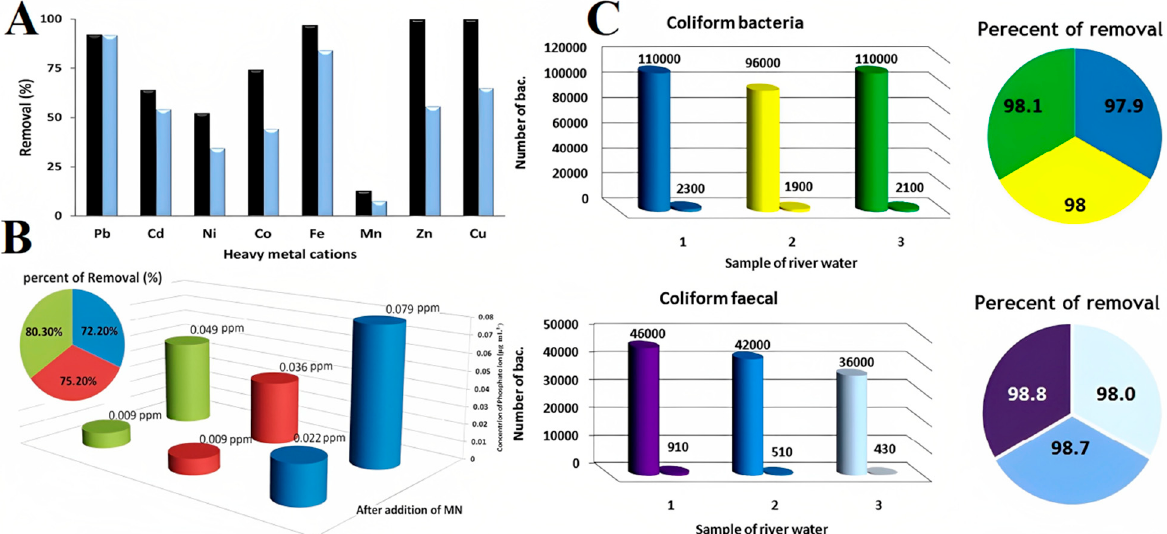
Figure 13. ( A ) Removal percentage of heavy-metal cations with MNPs at two different concentrations of heavy-metal cations and constant water volume (conditions: adsorbent, 0.15 g; volume, 200 mL; concentrations of heavy metal cations, 1 μ g·mL − 1 (black bar) and 4 μ g·mL − 1 (blue bar); temperature, 25 °C); ( B ) effect of MNPs on phosphate ion removal. Concentrations before and after treatment and removal efficiency are shown in the pie chart (volume of water, 100 mL; pH, 8.3); ( C ) antibacterial activity of MNPs in the presence of coliform bacteria and coliform fecal bacteria in real water samples (the number of bacteria before and after treatment, n = 3). Reprinted with permission from Ref. [136]. Copyright 2016, Elsevier.